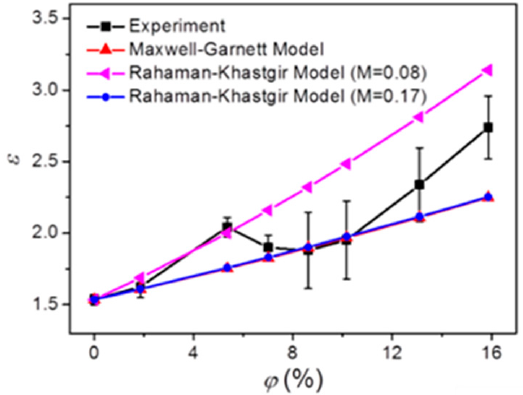
Figure 4. Experimental and theoretical dielectric constants ( ε ) of mZrO 2 @AF 1600 nanocomposite films under different mZrO 2 volume fractions ( φ ).